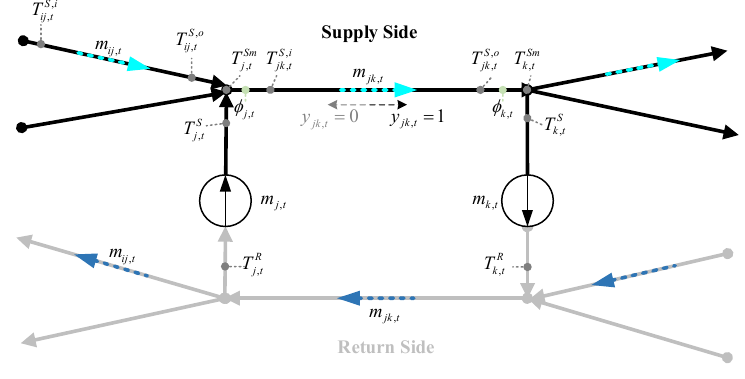
Figure 3. Structure of the district heating network.